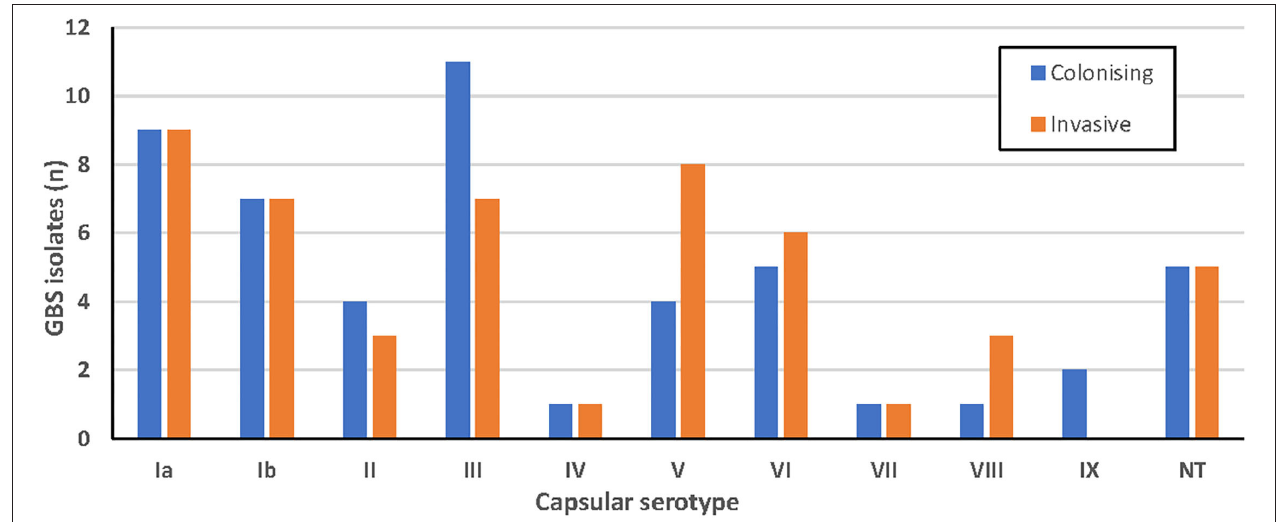
FIGURE 1 | Serotypes of colonizing (blue; n = 50) and invasive (orange; n = 50) GBS isolates obtained using latex agglutination.